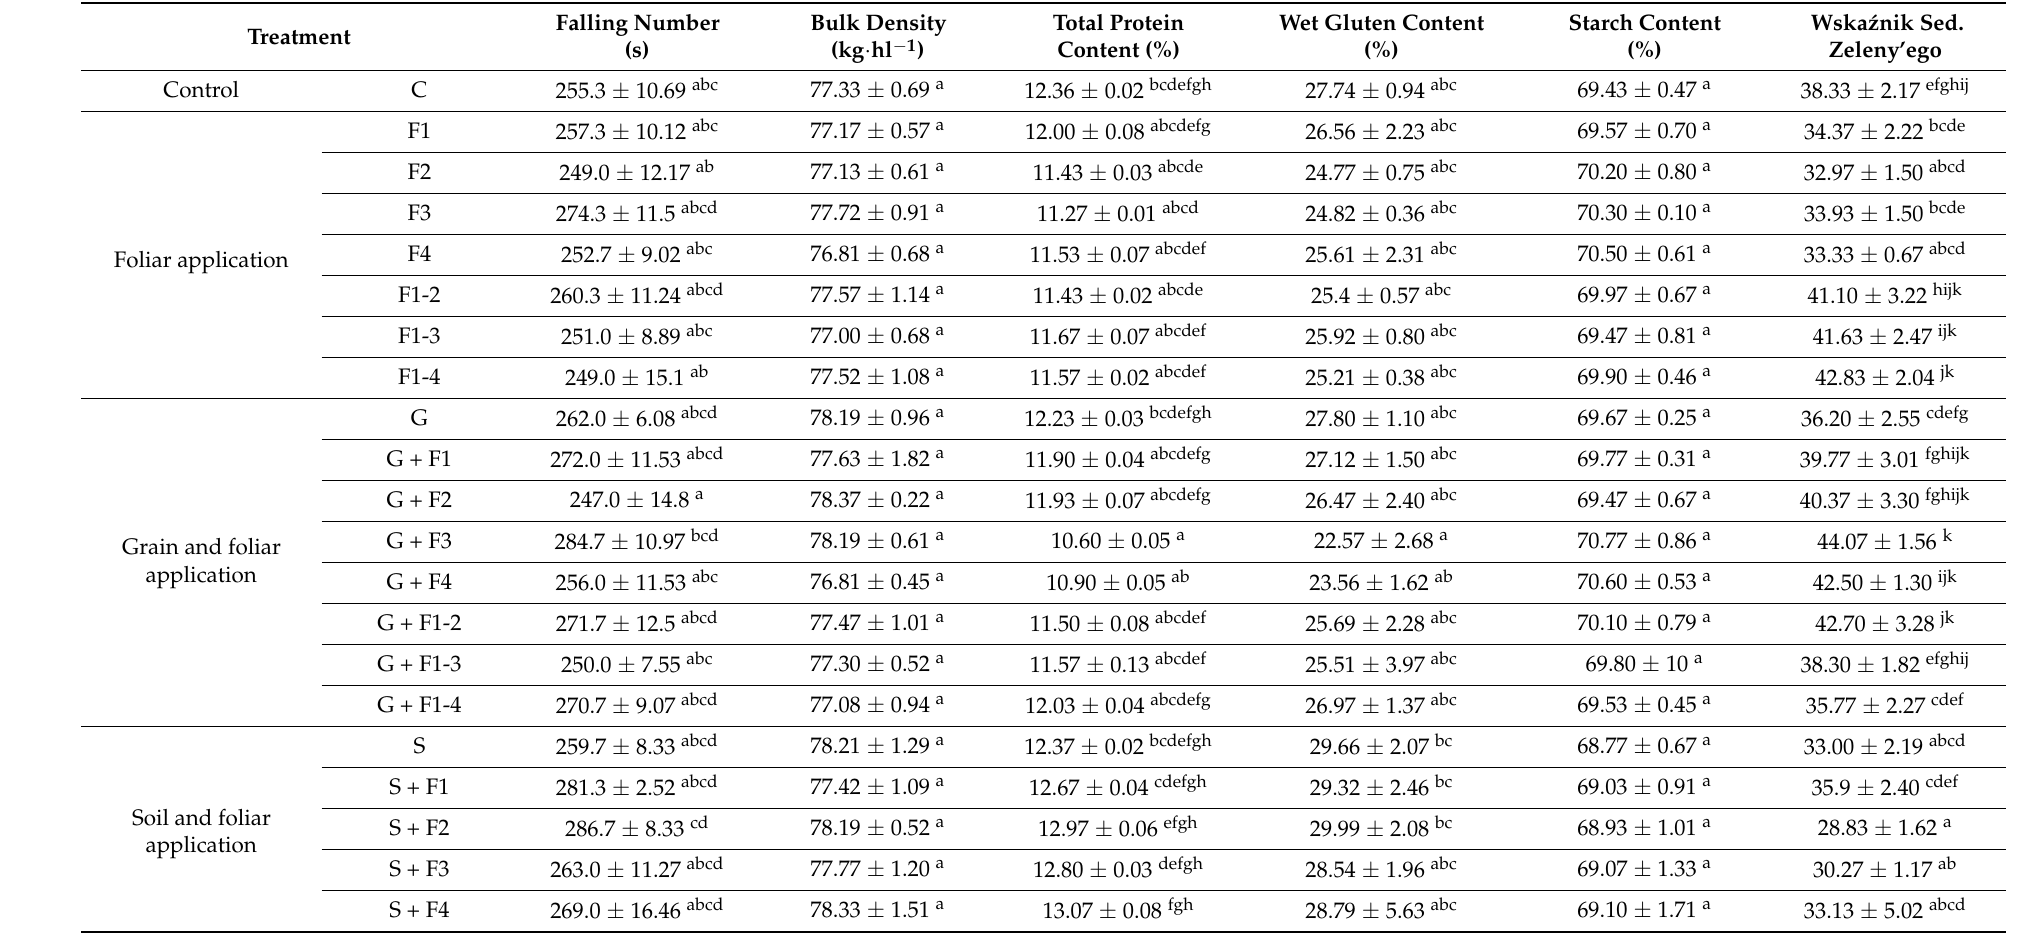
Table 4. Quality features of